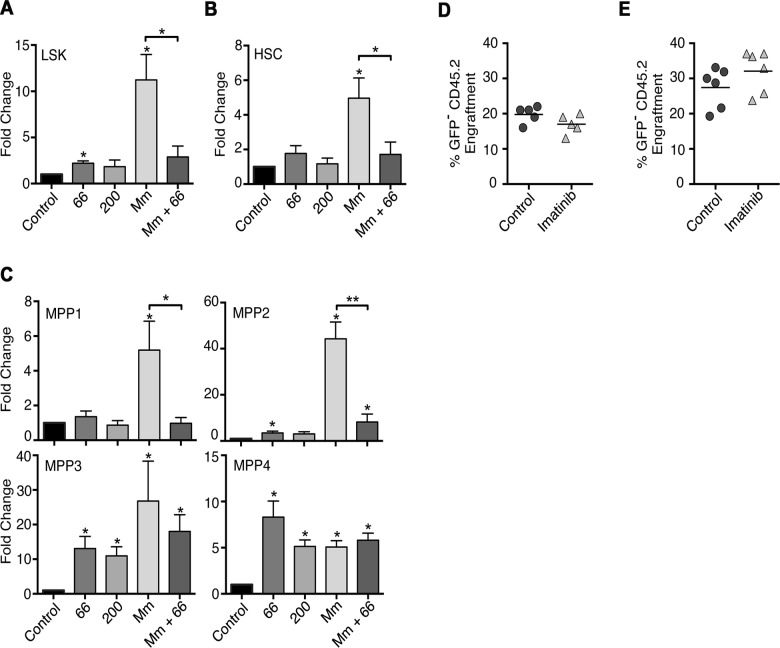
Effects of Imatinib on HSCs and multipotent progenitors in vivo.
(A-C) C57Bl/6 mice were administered imatinib at 66 or 200mg/kg/d or left untreated. Beginning 24h post-treatment mice were either injected in the tail vein with 105 CFU Mm 1218R or left uninfected. Bone marrow was collected from femurs and HSCs and MPPs enumerated by flow cytometry[41]. (A-C) Effect of imatinib or infection on Linnegsca1+CD117+ (LSK) cells (A), HSCs (CD34−CD48−CD150+CD135−) (B) or MPP1 (CD34+CD48-CD150+CD135−), MPP2 (CD34+CD48+CD150+CD135−), MPP3 (CD34+CD48+CD150−CD135−) and MPP4 (CD34+CD48+CD150−CD135+) cells (C). Each bar represents the average fold change relative to control in 2–6 independent experiments with 3–6 animals per condition per experiment. An asterisk (*) above the error bar indicates statistical significance compared to control as determined by t-test. Statistical significance was also assessed for infected (Mm) versus infected, drug treated animals (Mm + imatinib) and is indicated by a bracket over the bars. (D-E) Competitive bone marrow transplants with whole marrow (D) or LSK cells (E) from control animals or animals treated with 66mg/kg/d imatinib for 7d. (D) Congenic CD45.1+ C57Bl/6 mice were lethally irradiated and transplanted with 2 x 106 whole bone marrow cells from untreated GFP+ C57Bl/6 donors mixed with 2 x 106 whole bone marrow cells from C57Bl/6 (CD45.2) donors that were either treated with imatinib for seven days or left untreated. Numbers of leukocytes derived from the different donor sources or the recipient mice were determined by flow cytometry at 4 months post transplant (n = 5 recipient mice per condition). (E) GFP+ C57Bl/6 marrow (3x105 cells) was mixed with 5x103 sorted LSK cells before transplantation, and donor chimerism was determined using blood drawn 4 months post-transplantation (n = 5 recipient mice per condition). A Mann-Whitney nonparametric test was used to determine significance.